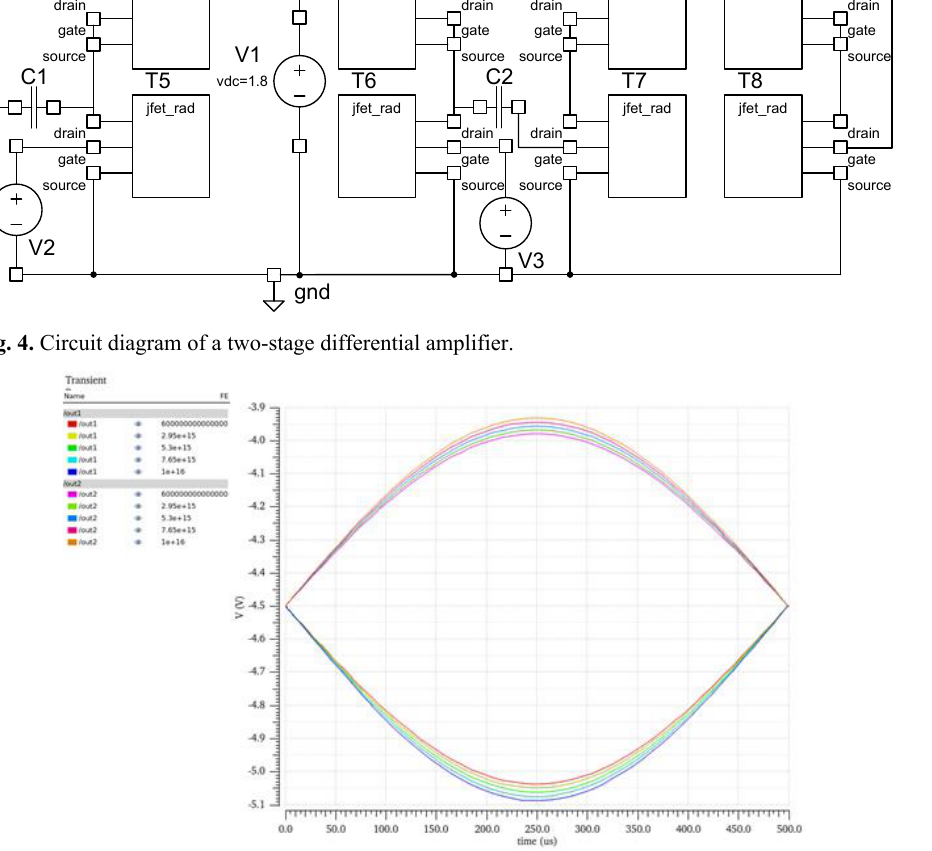
Fig. 5. Time diagram of a two-stage differential amplifier under normal